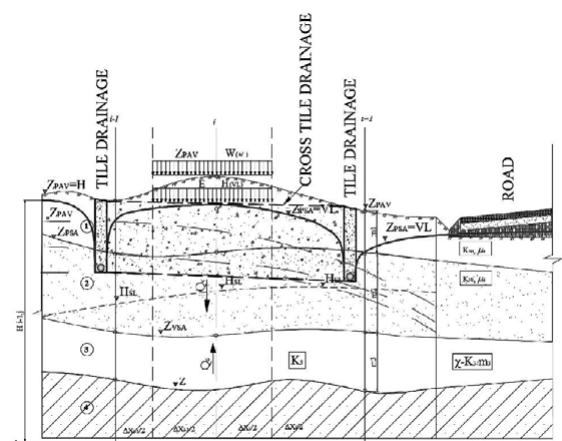
Fig. 1. The scheme of steady water flow into perfect drain Note: μ – water retention coefficient; Z PAV ( H ) – height of water pressure with regard to reference plane, m; M – saturated permeability of upper watery layers; W – intensity of infiltration or filtration, m/day; Z PSA ( VL ) – altitude of layer surface, m; Z VSF – altitude of layer bottom, m; ε( z ) – intensity of evaporation from water surface; E 0 – evaporation from the modelling area, m/day; γ n – empiric coefficient, dependent on species of flora; z – depth of groundwater; K 3 – 3 rd layer filtration coefficient, m/ day; m 3 – 3 rd layer filtration thickness, m; H SL – pressure height of pressure water (in the 4 th